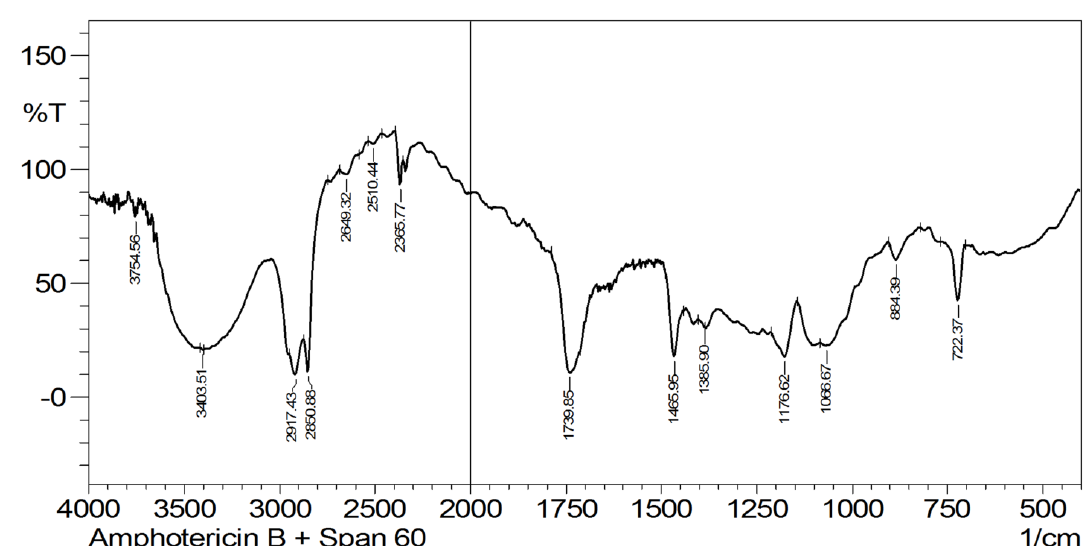
FIGURE 3 - FTIR spectrum of optimized formulation S1.